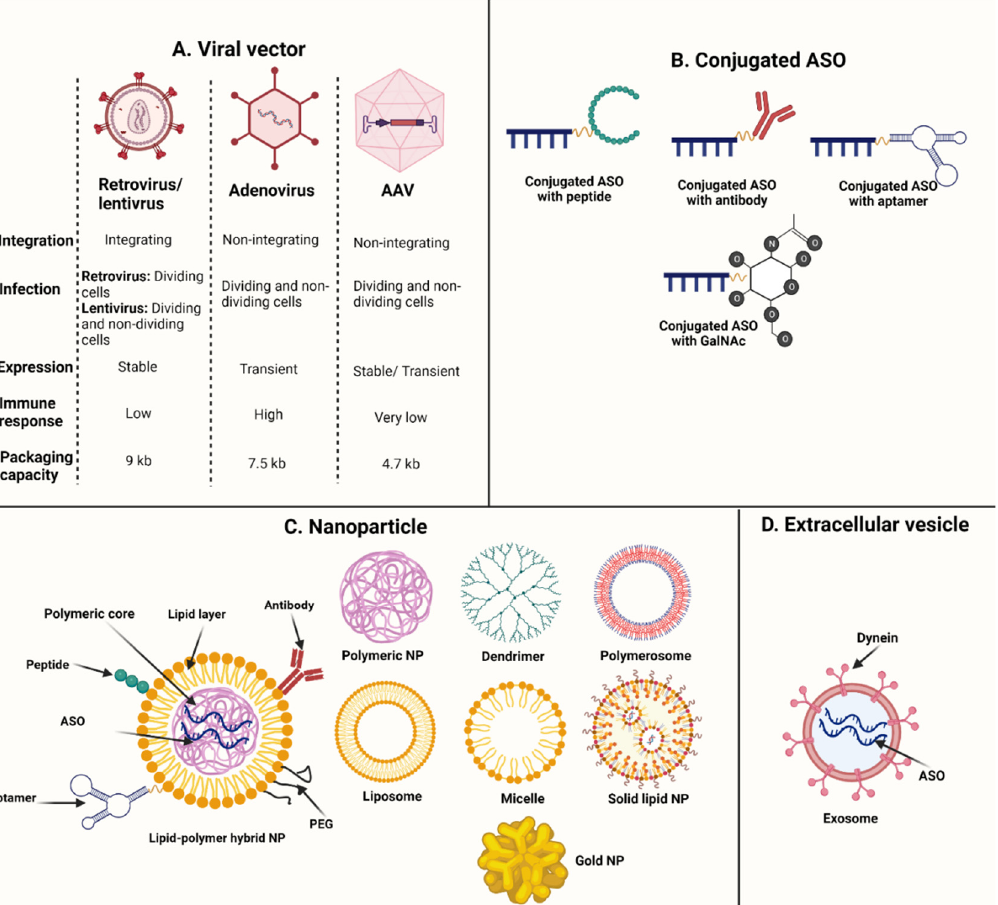
Figure 4. Antisense oligonucleotides can be delivered into the cells more efficiently using ( A ) viral vectors, ( B ) conjugated peptides, antibodies, and other ligands (e.g., aptamers and acetylgalactosamine (GaINAc)), ( C ) nanoparticles, or ( D ) extracellular vesicles. “Schematic diagram created with premade icons and templates from biorender.com (accessed on 20 August 2022).”